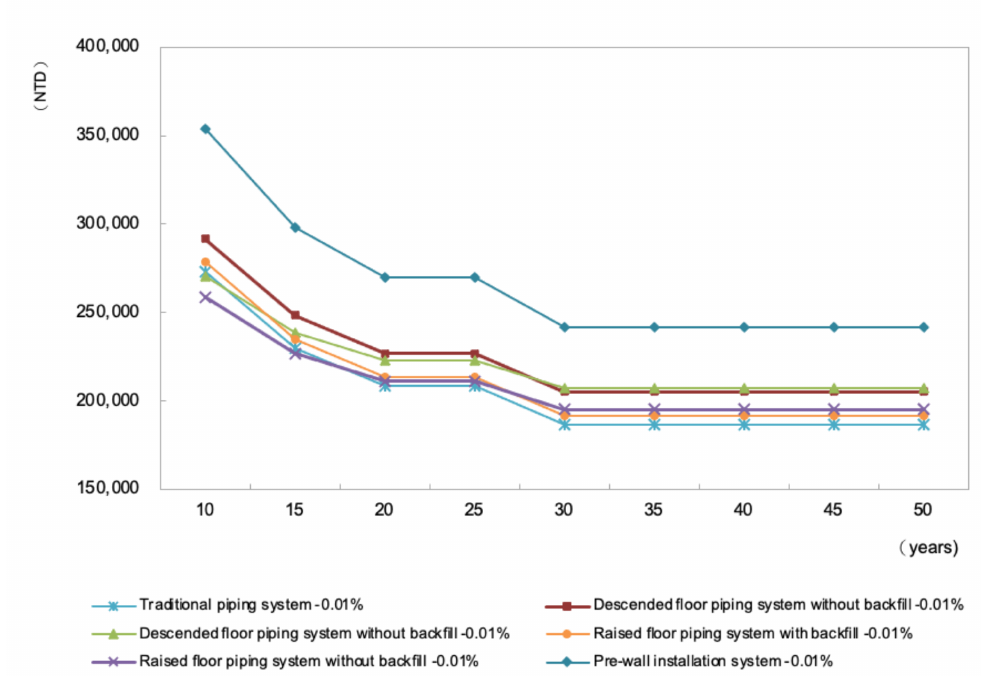
Figure 8. Life cycle costs for the partial replacement of pipelines in the four types of bathroom piping systems with discount rate of − 0.01%.